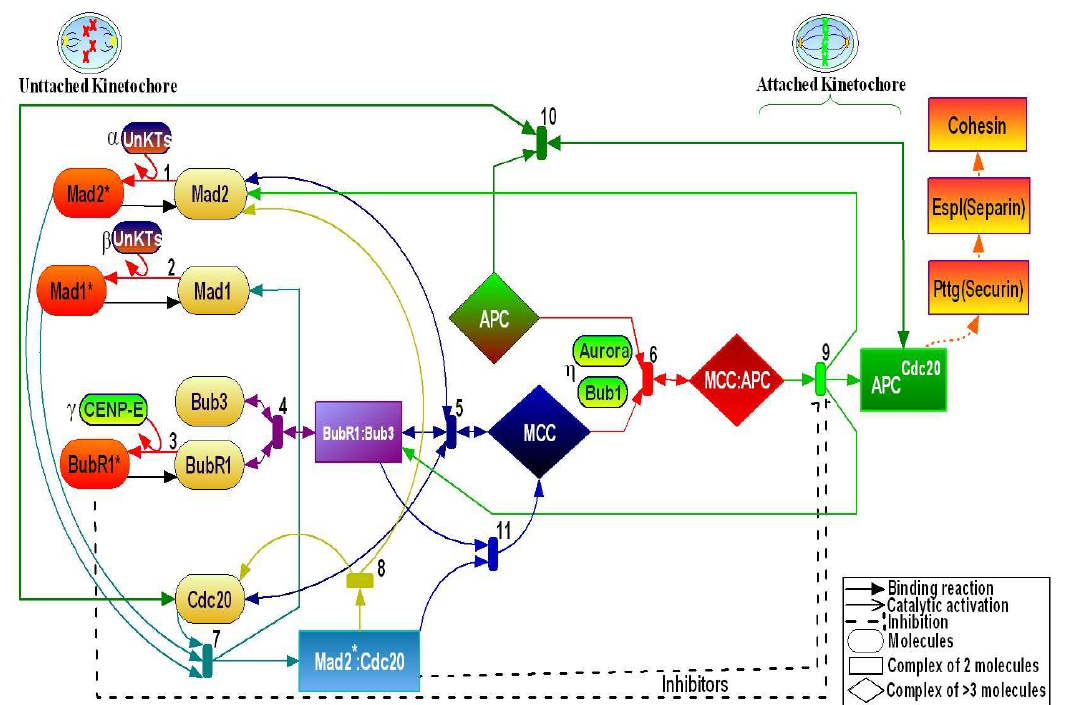
Figure 2: Reaction network for one compartment. The activation reactions with parameters α, β, and γ continue, as long as the kinetochore is unattached (left). When the respective kinetochore attaches, α, β, and γ are set to 0. A network of reactions leads to the formation of the MCC:APC complex (middle). These reactions continue as long as there is at least one unattached kinetochore. This is the consequence of the diffusion in the system, because the respective kinetochore does not any longer supply activated Mad1 ∗ , Mad2 ∗ , and BubR1 ∗ . When the last kinetochore attaches, the APC:Cdc20 complex begins to form and leads to a cascade of reactions cutting cohesin in the end and initiating anaphase